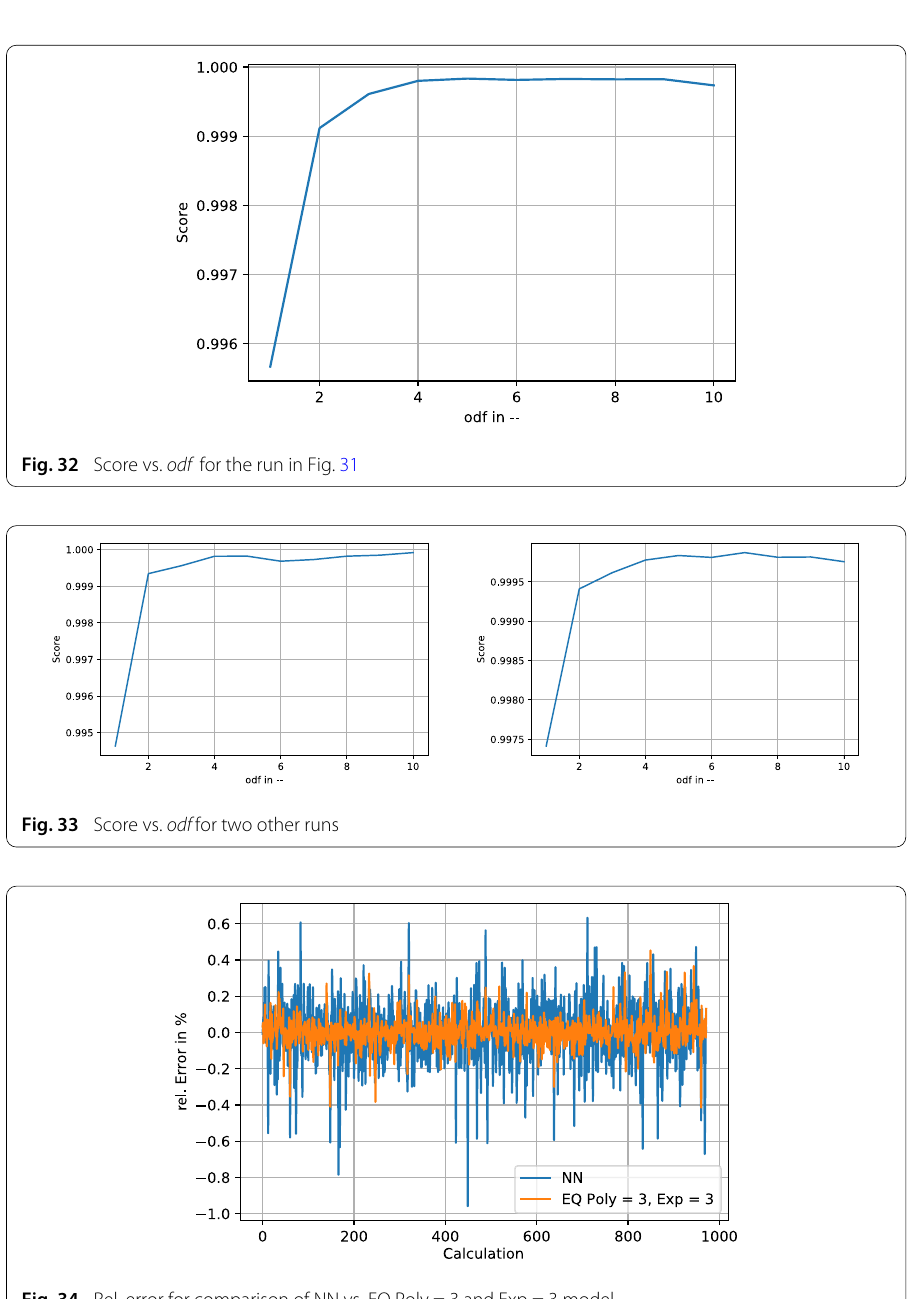
The characteristic variations are predicted close to the dashed comparison-lines. This is also valid for the system-parameters which were predicted unphysically by the pure polynomial models. Compared to the right plot of Fig. 28 the exponential model is closer to the validation